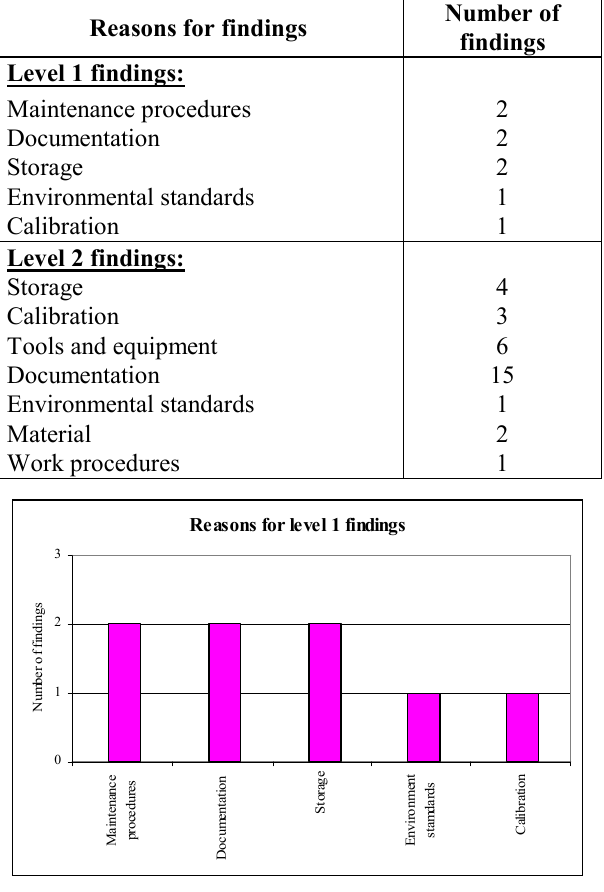
Fig 5. The reasons for level 1 finding in organization YYY Reasons for level 2 findings